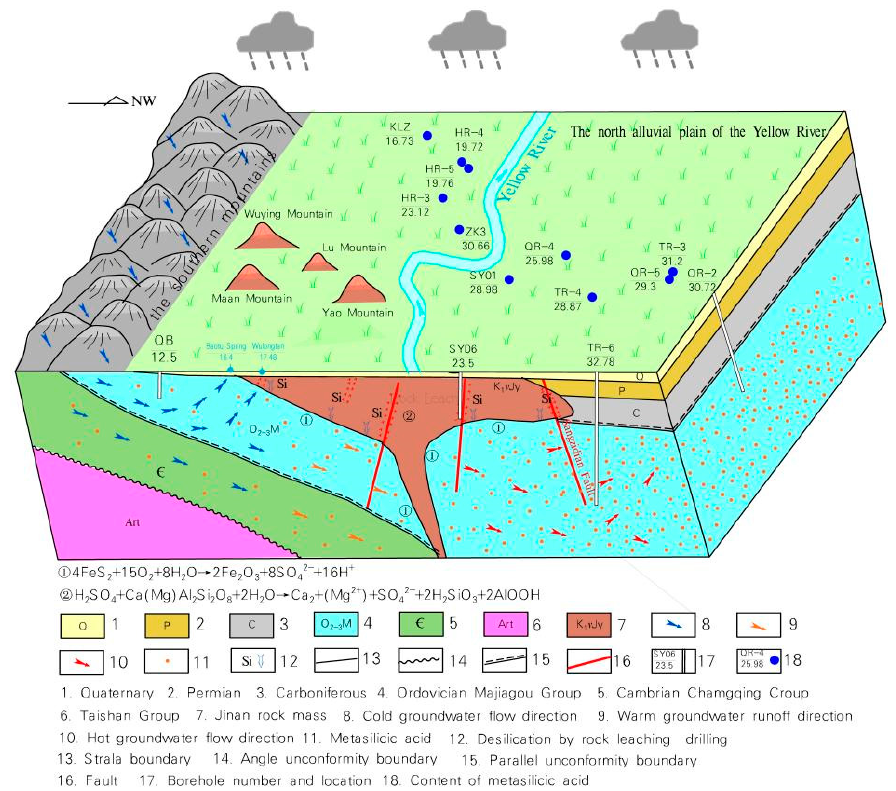
Figure 10. Genetic model of the metasilicate-rich groundwater around Ji’nan rock